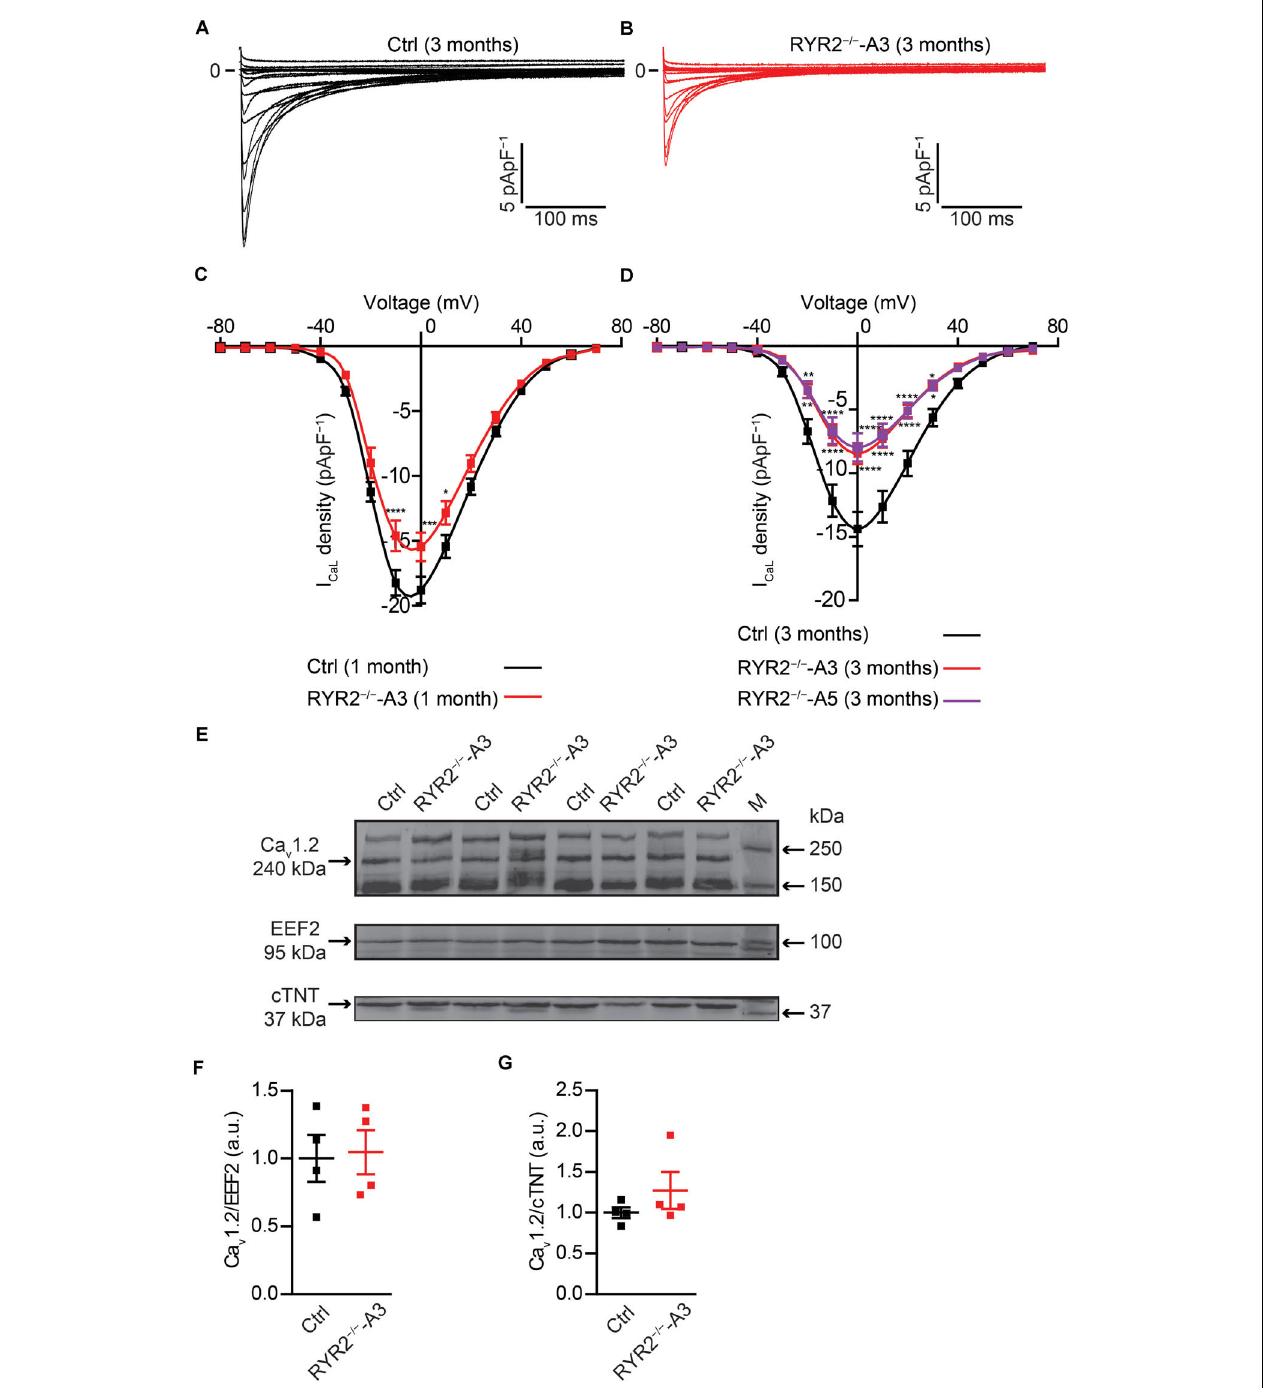
FIGURE 9 | Electrophysiological analysis of I CaL in Ctrl- and RYR2 − / − -iPSC-CMs. (A,B) Representative I CaL traces of 3-month-old Ctrl- (A) and A3 RYR2 − / − -iPSC-CMs (B) . (C) Average current-voltage (I–V) curves for peak I CaL in 1-month-old Ctrl- and RYR2 − / − -iPSC-CMs (Ctrl: n = 12 cells from three differentiation experiments; RYR2 − / − : n = 15 cells from two differentiation experiments). (D) Average current-voltage (I–V) curves for peak I CaL in 3-month-old Ctrl- and RYR2 − / − -iPSC-CMs (Ctrl: n = 32 cells from four differentiation experiments; A3 RYR2 − / − : n = 24 cells from three differentiation experiments; A5 RYR2 − / − : n = 18 cells from two differentiation experiments). * P < 0.05; ** P < 0.01; *** P < 0.001; **** P < 0.0001 RYR2 − / − vs. Ctrl by the two-way ANOVA with Sidak’s multiple comparison test. (E–G) Western blot analysis of the voltage-dependent calcium channel alpha 1C subunit (Ca v 1.2) in Ctrl- and A3 RYR2 − / − -iPSC-CMs. Protein levels of Ca v 1.2 normalized to EEF2 (F) and cTNT (G) in Ctrl- and A3 RYR2 − / − -iPSC-CMs. Ctrl: n = 4 and A3 RYR2 − / − : n = 4 independent differentiation experiments.